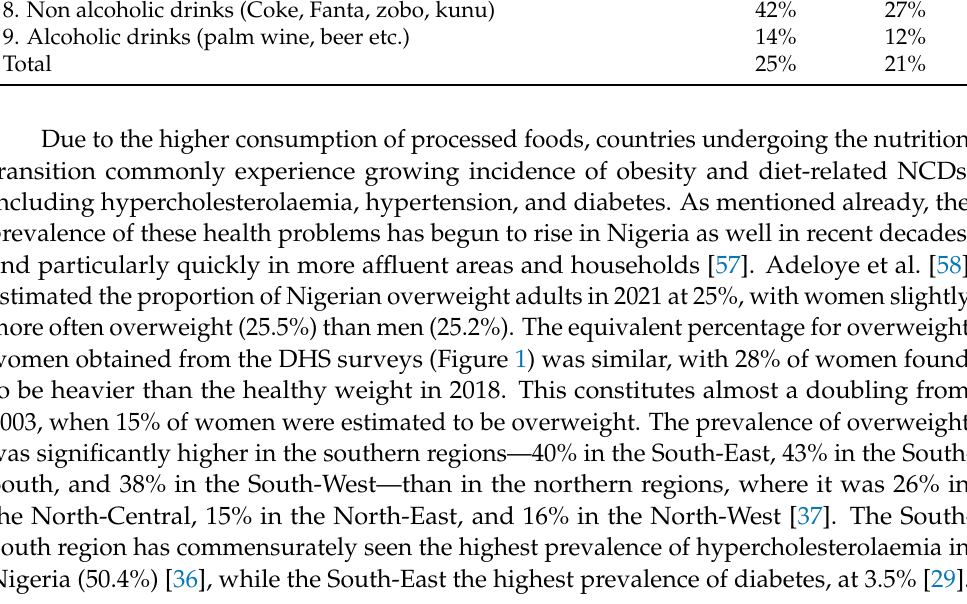
Table 8. Meals eaten out of home in the 7 days prior to the survey in 2018 versus 2010 [11,12]. Eating Out in the Past 7 Days